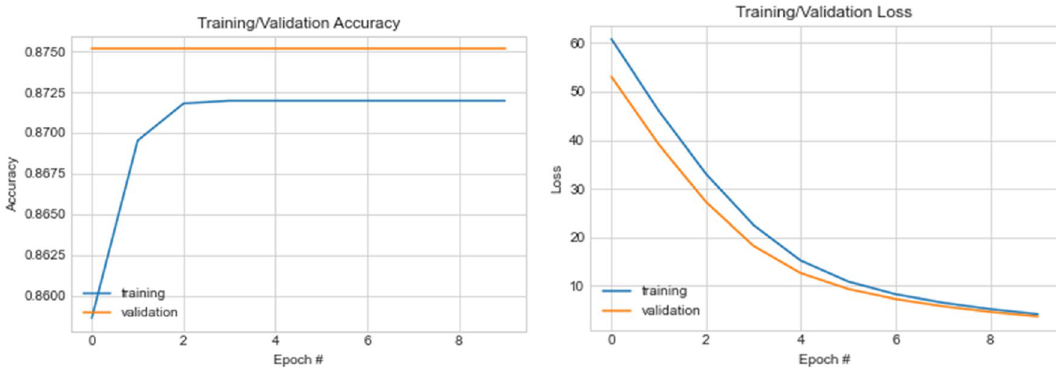
Figure 15. A graphical illustration of accuracy and loss value distribution for ten (10) epochs on the wavelet- CNN model using CLAHE + WPD samples.